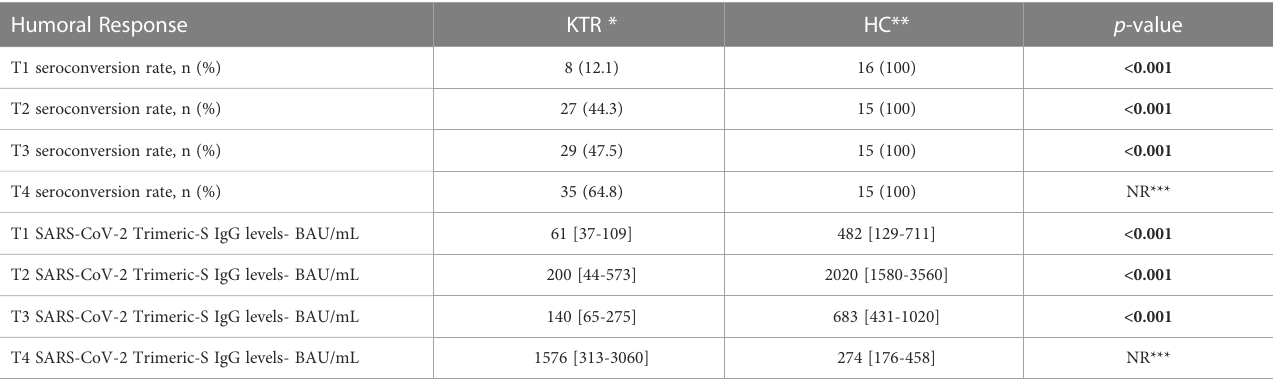
TABLE 1 Humoral response to COVID-19 vaccination in KTR and HC group. Humoral